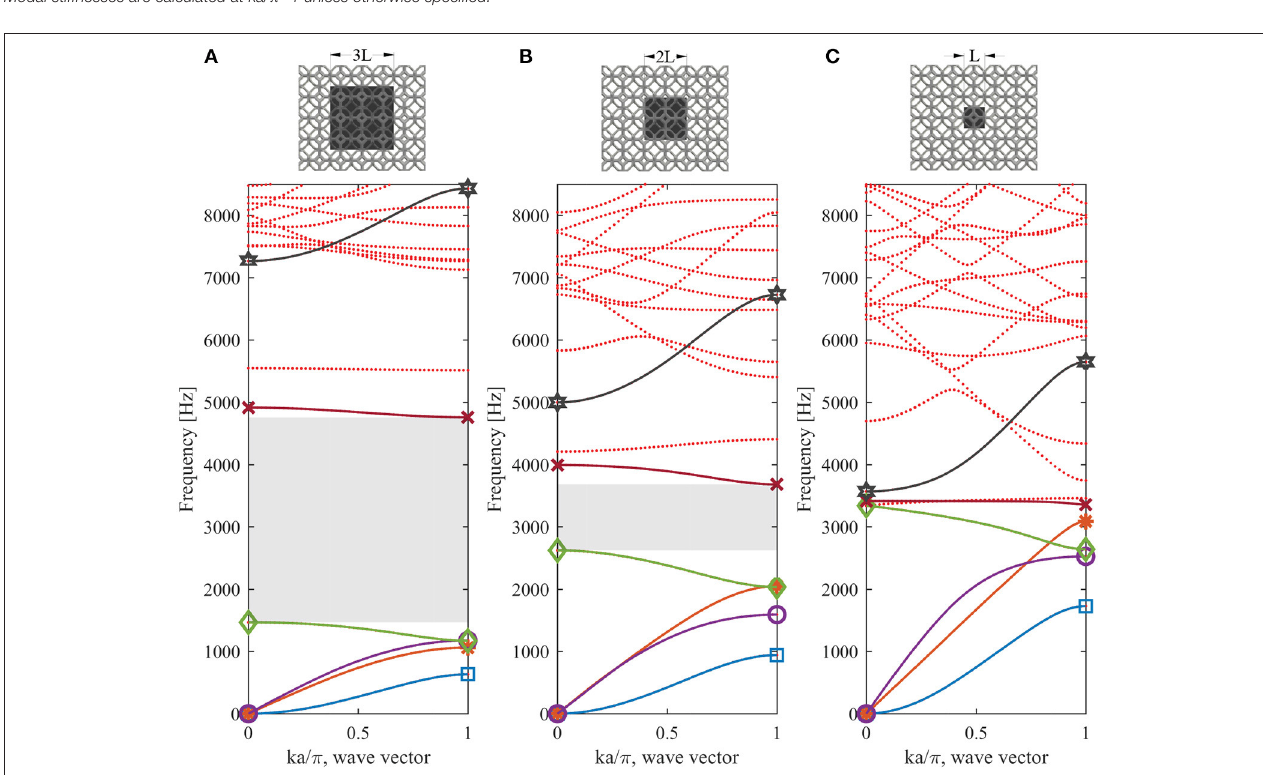
FIGURE 6 | Dispersion relations for the Kelvin metastructure with lattice relative density of 8.3% and resonator side length equal to (A) 3L , (B) 2L , and (C) L . The lowest band gaps are indicated by gray boxes. Markers indicate the edge frequencies of modes of interest: 1st bending resonator mode (blue-square), torsional resonator mode (orange-asterisk), axial resonator mode (purple-circle), 2nd bending resonator mode (green-diamond), torsional lattice mode (red-cross), and axial lattice mode (gray-star).